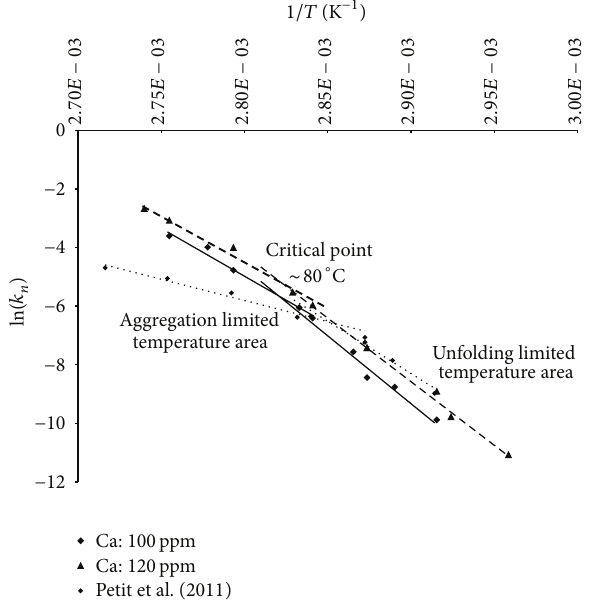
Figure 5: Arrhenius plot for the 𝛽 -Lg denaturation of 1% (w/w) WPI fouling solutions at various calcium concentrations (100 and 120 ppm).